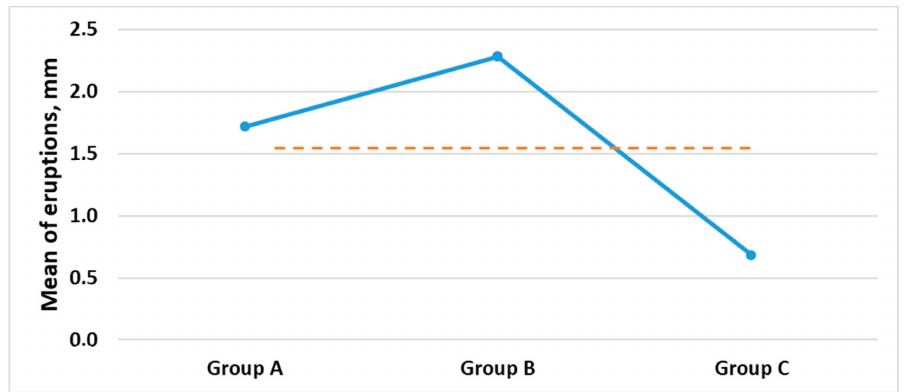
Figure 12. Mean of eruption in mm in the interval T1 ‐ T2.